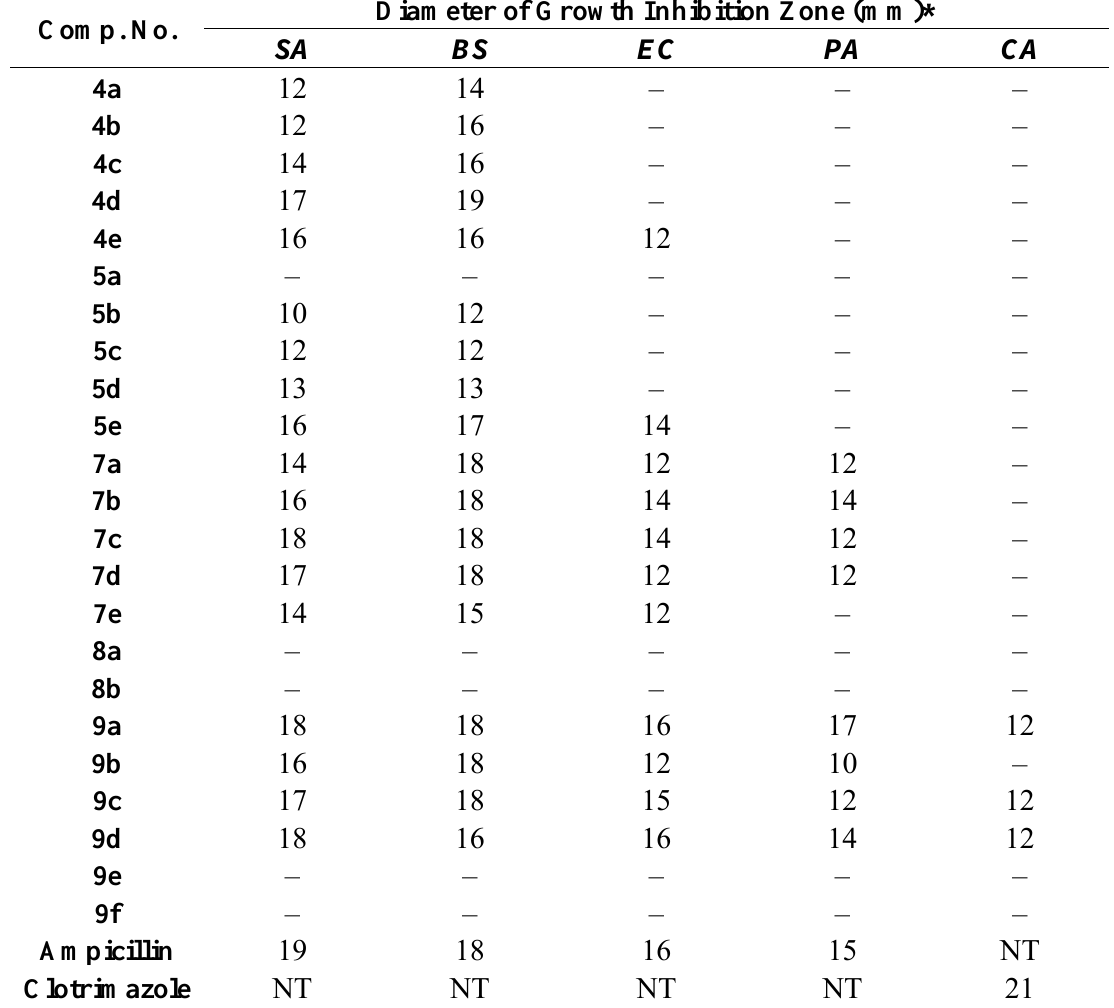
Table 2. Antimicrobial activity of compounds 4a–e , 5a–e , 7a–e , 8a, b and 9a–f (200  g/8 mm disc), the broad spectrum antibacterial drug ampicillin (100  g/8 mm disc) and the antifungal drug clotrimazole (100  g/8 mm disc) against Staphylococcus aureus IFO 3060 ( SA ), Bacillus subtilis IFO 3007 ( BS ), Escherichia coli IFO 3301 ( EC